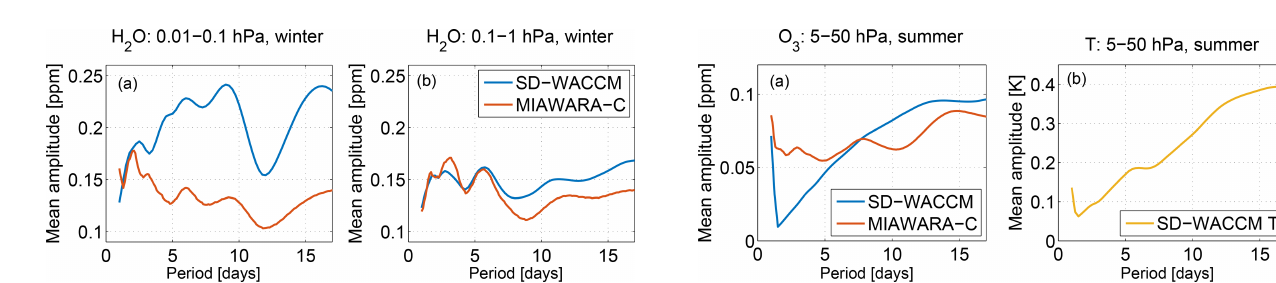
Figure 16. Mean amplitude for periods of 1–17d obtained by band- pass filtering the water vapour time series of MIAWARA-C and SD-WACCM. The signal is averaged for the pressure ranges 0.01– 0.1hPa (a) and 0.1–1hPa (b) and for ± 40d around winter solstice of the years 2015–2017.